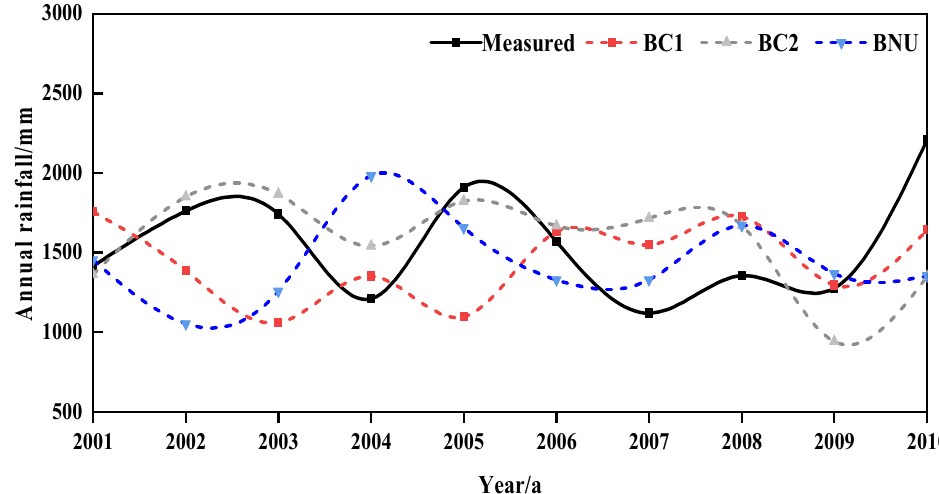
Figure 5. Comparison of measured and simulated precipitation values from 2001 to 2010.